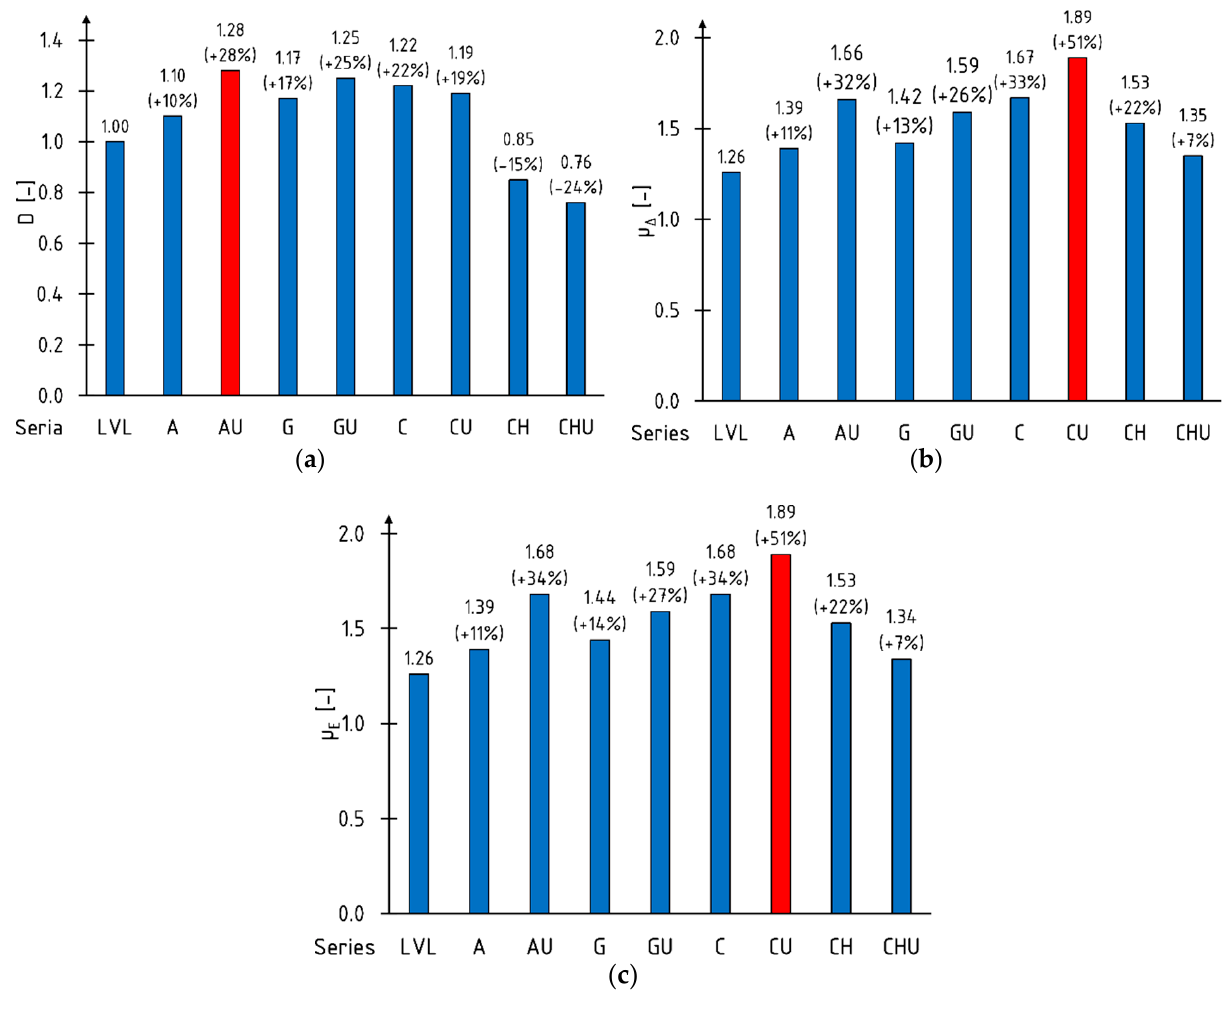
Figure 7. Ductility indices: ( a ) D ; ( b ) µ Δ ; ( c ) µ E .